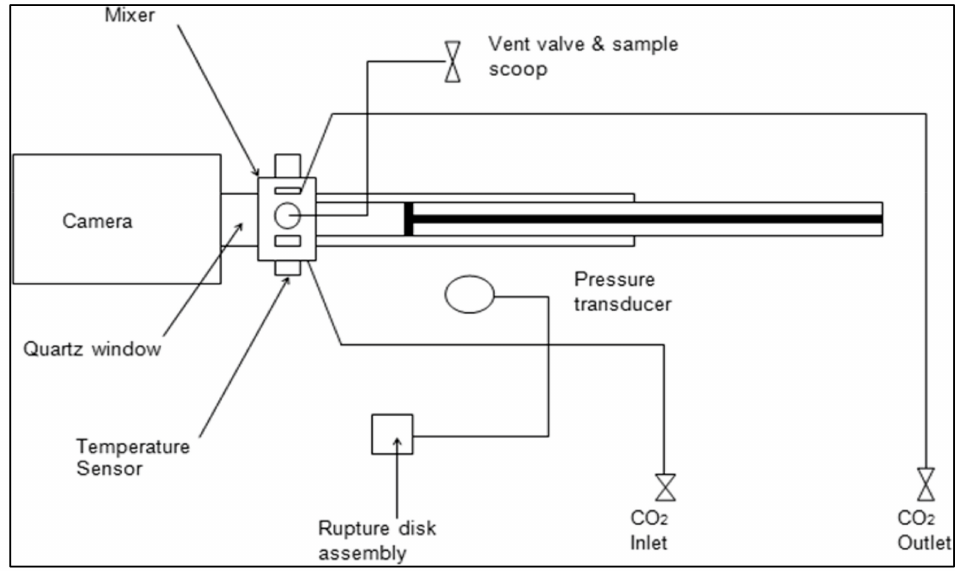
Figure 3. Schematics of supercritical phase